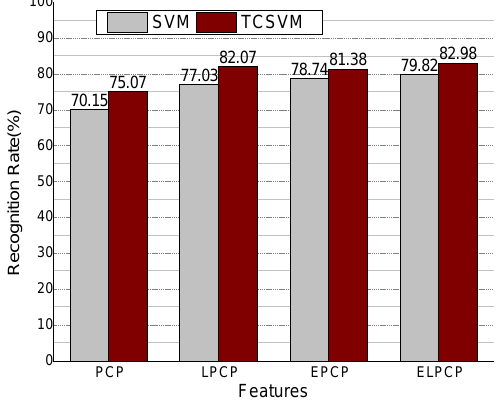
Figure 8. Recognition rates with different features.